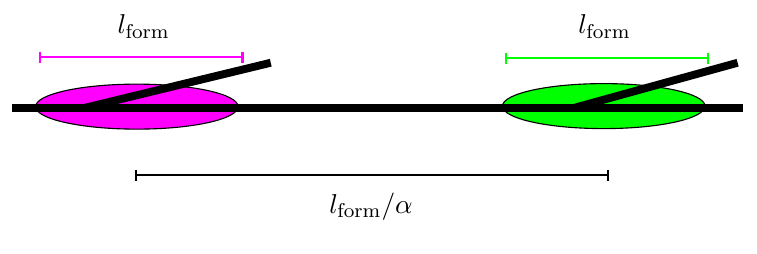
Figure 4 . The hierarchy of scales